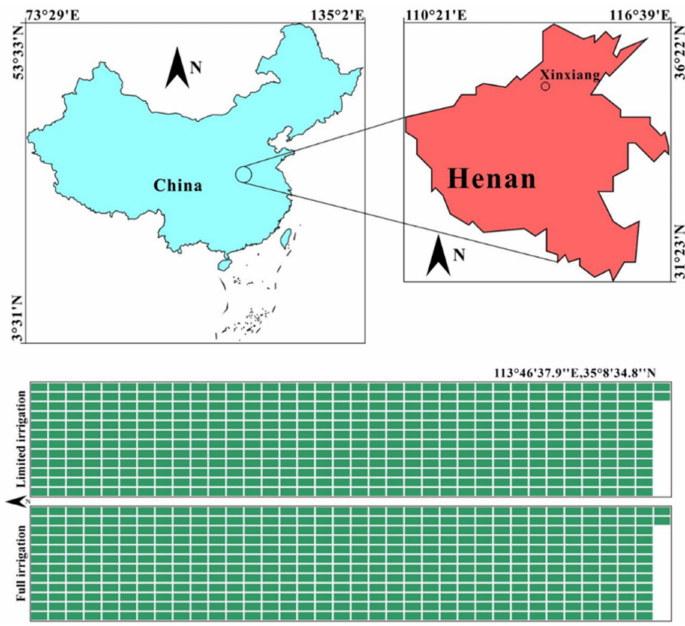
Figure 1. Field location and experimental